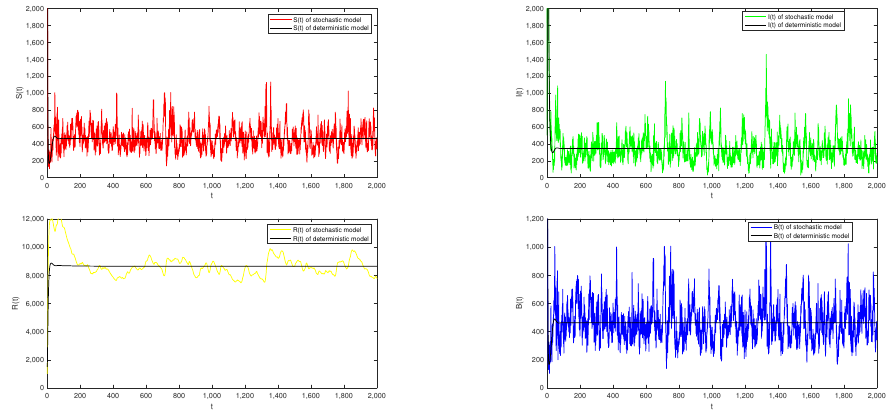
Figure 2. Paths of the deterministic model (1) and the corresponding stochastic model (2) with σ 1 = σ 2 = 0.1.